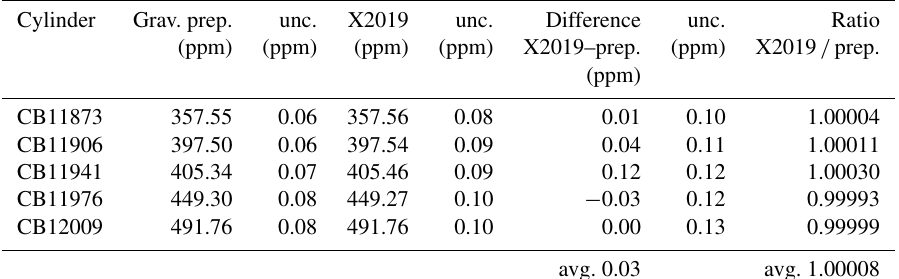
Table 3. Comparison of gravimetrically prepared standards to the X2019 scale (prep. stands for prepared value; unc. stands for standard uncertainty, ∼ 68% confidence level). Gravimetric standards were analyzed by laser